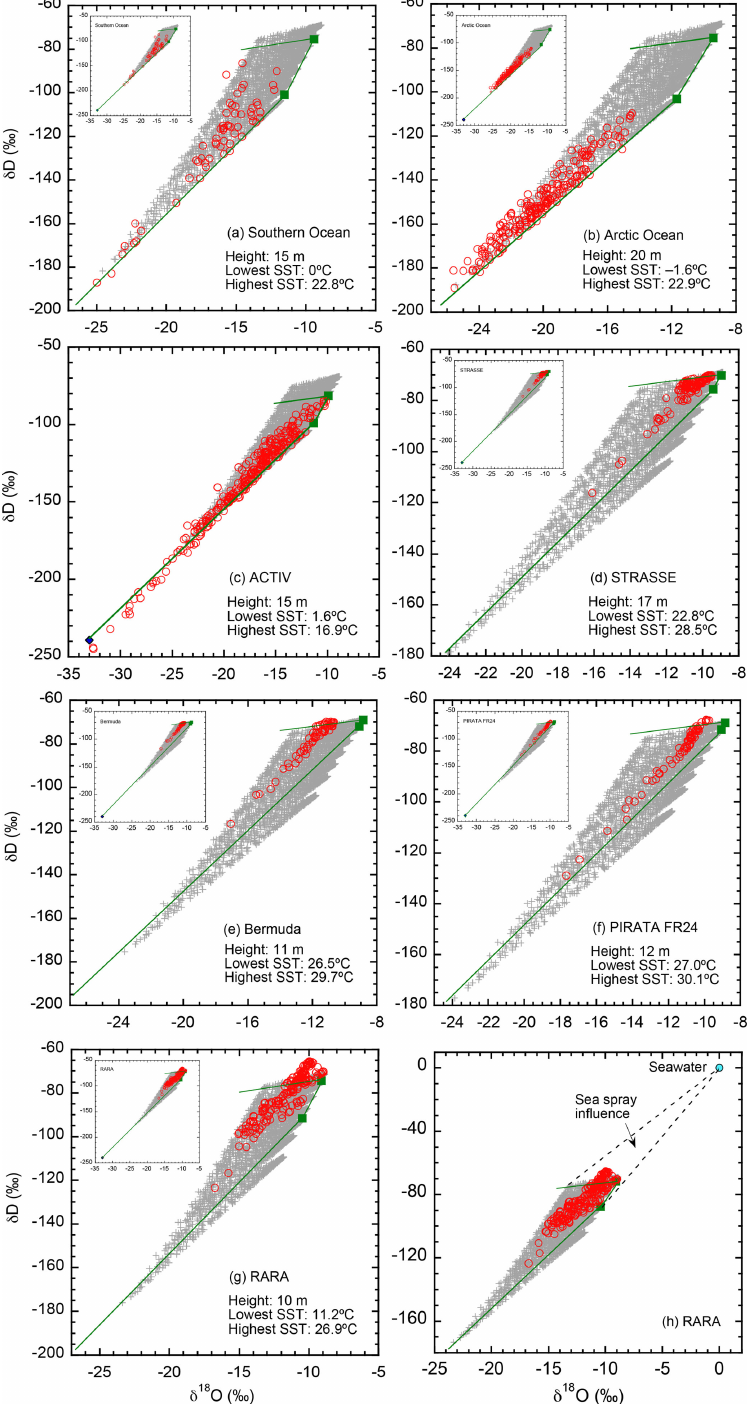
Figure 5. Comparisons between simulated and observed isotopic ratios for each of the seven cruises (a–g) , and a redraw of the RARA data with ocean water composition indicated (h) . For each cruise, the simulated values are calculated at the height of the observations, indicated in the plot. If not otherwise indicated, calculated isotopic values are shown as crosses ( + ), the values of the descending air as a diamond ( (cid:7) ), and observations as red circles ( (cid:13) ). For each cruise, vapor in equilibrium with lowest and highest SSTs is shown as two green squares ( (cid:4) ), with the temperature values indicated in the plot. Solid lines border the theoretical limits of isotopic distributions under the cruise conditions and model assumptions. For (a–g) , unless the depleted, descending air is indicated in the main graph by a blue diamond (all but c ) it is shown in the